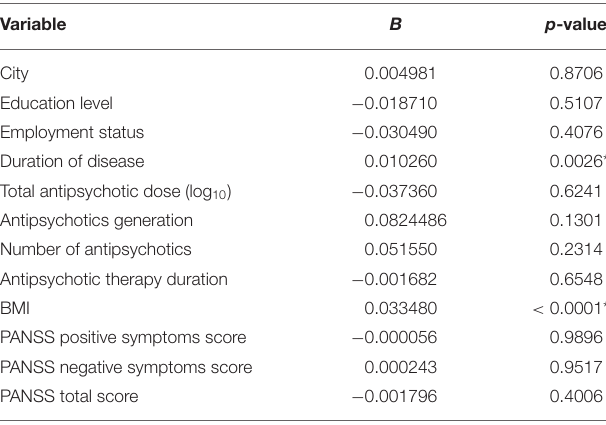
TABLE 14 | Determinants of MetS in multiple regression